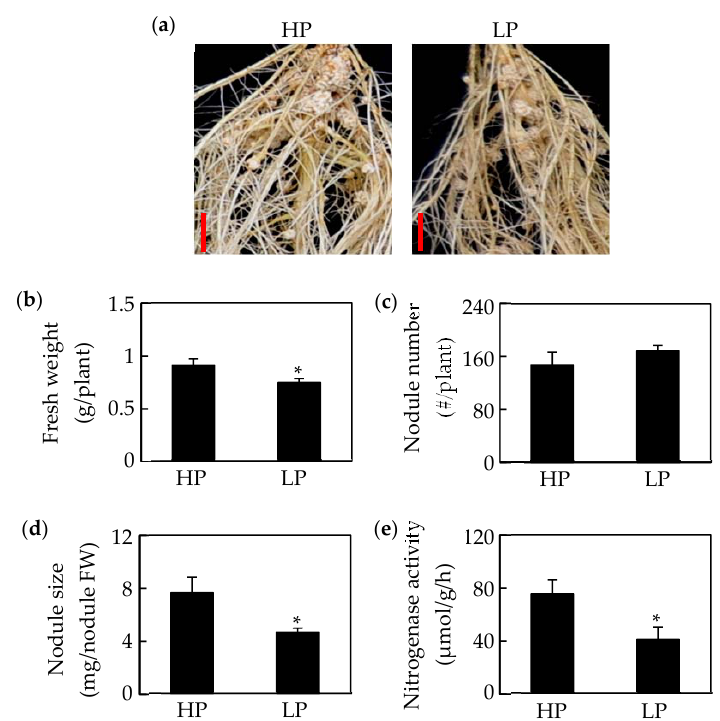
Figure 1. Effects of phosphorus (P) deficiency on soybean nodule growth. ( a ) Phenotype of soybean nodules at two P levels. ( b ) Soybean fresh weight. ( c ) Nodule number. ( d ) Nodule size. ( e ) Nodule nitrogenase activity. Data in the figure are mean of four replicates with standard error bars. Asterisks indicate significant difference between HP (500 µ M KH 2 PO 4 ) and LP (25 µ M KH 2 PO 4 ) treatments in the Student’s t -test (*: p < 0.05). Bars = 1 cm.